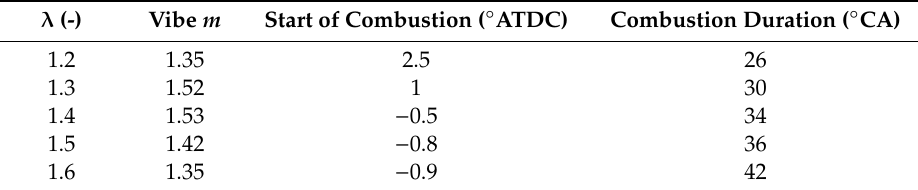
Table 7. Vibe coe ffi cient m and combustion